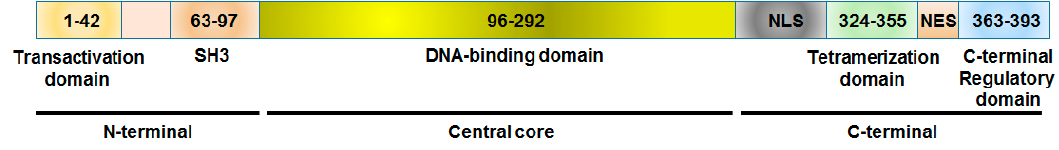
Figure 4. Schematic diagram showing the functional domains of the p53 tumor suppressor protein. Majority of P53 mutations found in human cancers are present in the DNA-binding domain. In addition some mutations are located in the tetramerization domain. SH3, Src homology 3 (SH3) domains; NLS, nuclear localization signal; NES, nuclear export signal. Table 1. P53’s interaction sites with the four E3 ubiquitin ligases discussed in this review. Mdm2, COP1, Pirh2 and Hsp70-CHIP distinct binding sites in the p53 protein allow these E3 ligases to often synergistically inhibit p53’s activities. * Current evidence shows that p53 uses the DNA binding domain to bind to the Hsp70–CHIP complex. The mutant form of p53 shows greater binding affinity to Hsp70. See the main text for details and related references. aa, Amino acid.